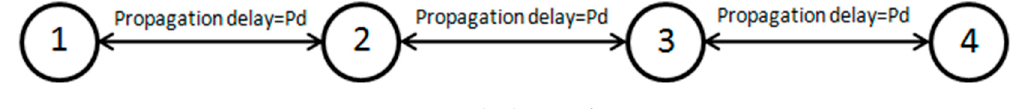
Figure 8. Calculation of T WTRL . Table 3. Setting T WACK and T WTRL .